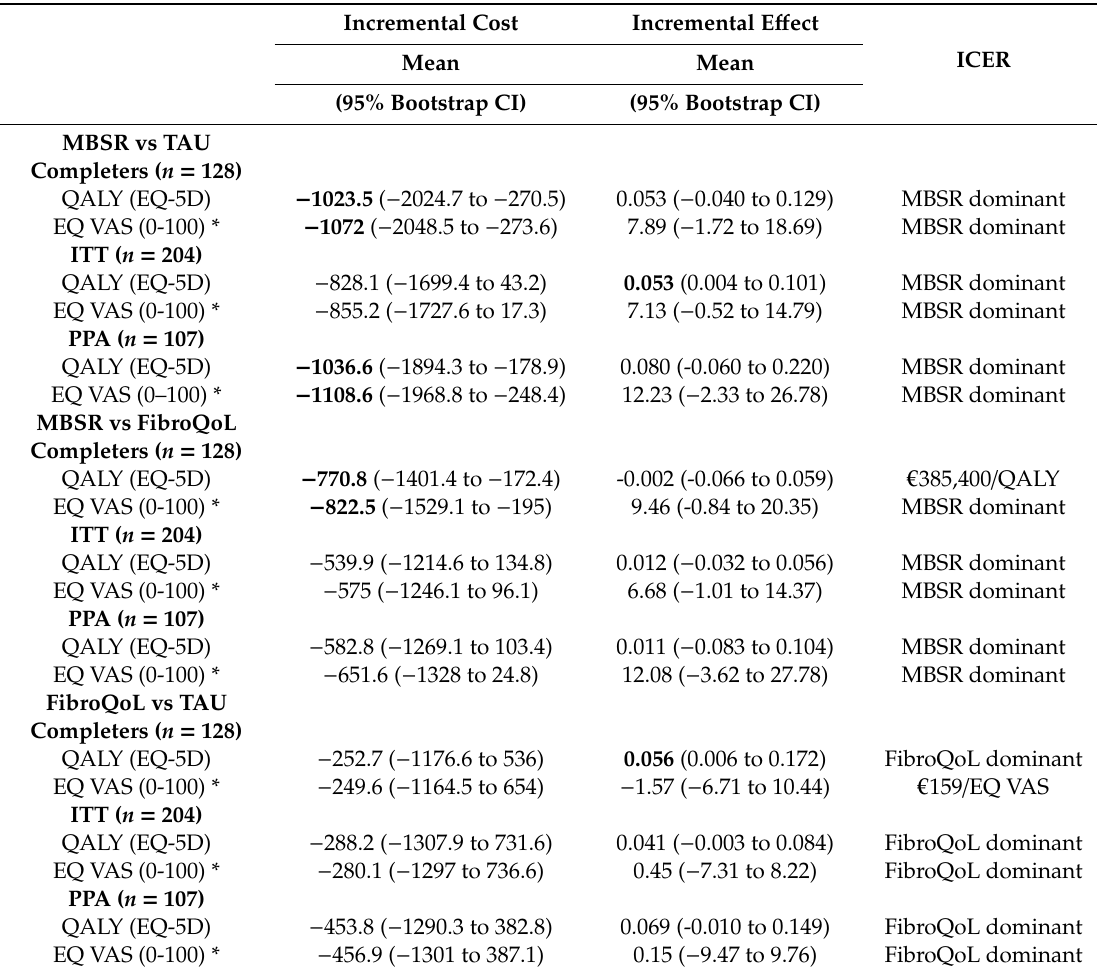
Table 4. Incremental cost, e ff ect, and cost-e ff ectiveness ratios from the government